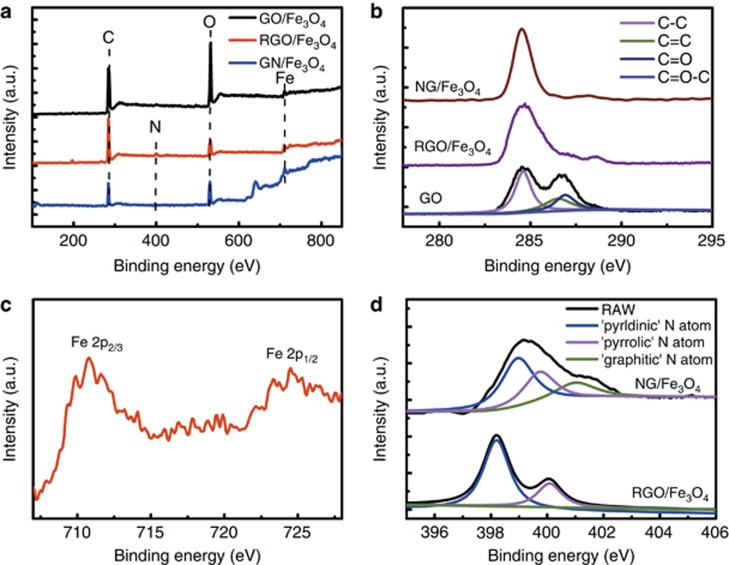
(a) XPS surveys of GO/Fe3O4, RGO/Fe3O4 and NG/Fe3O4; (b) XPS C 1s spectrum of the GO, RGO/Fe3O4 and NG/Fe3O4 samples; (c) XPS Fe 2p spectrum of the NG/Fe3O4 samples; (d) XPS N 1s spectrum of the NG/Fe3O4 and RGO/Fe3O4 samples.